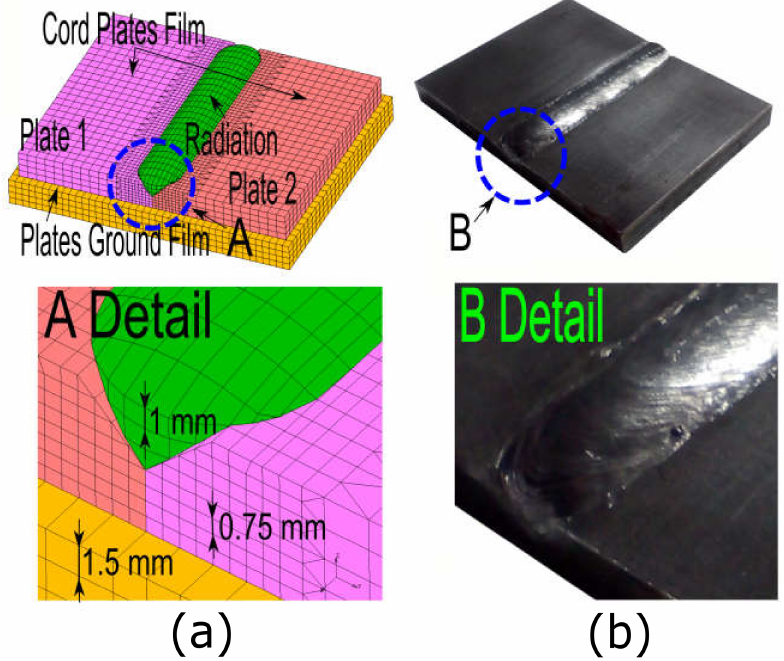
Figure 5. ( a ) Details of the mesh size considered for the proposed Finite Element (FE) models; and, ( b ) Detail of the starting and ending points of the weld bead studied, which also was included in the FE